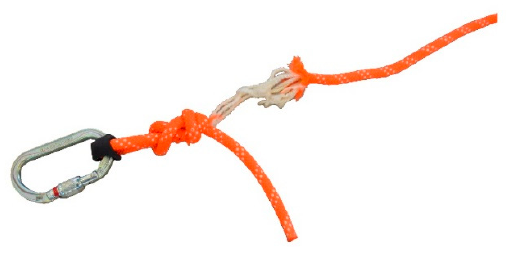
Figure 9. Failure of specimen in Test 10.